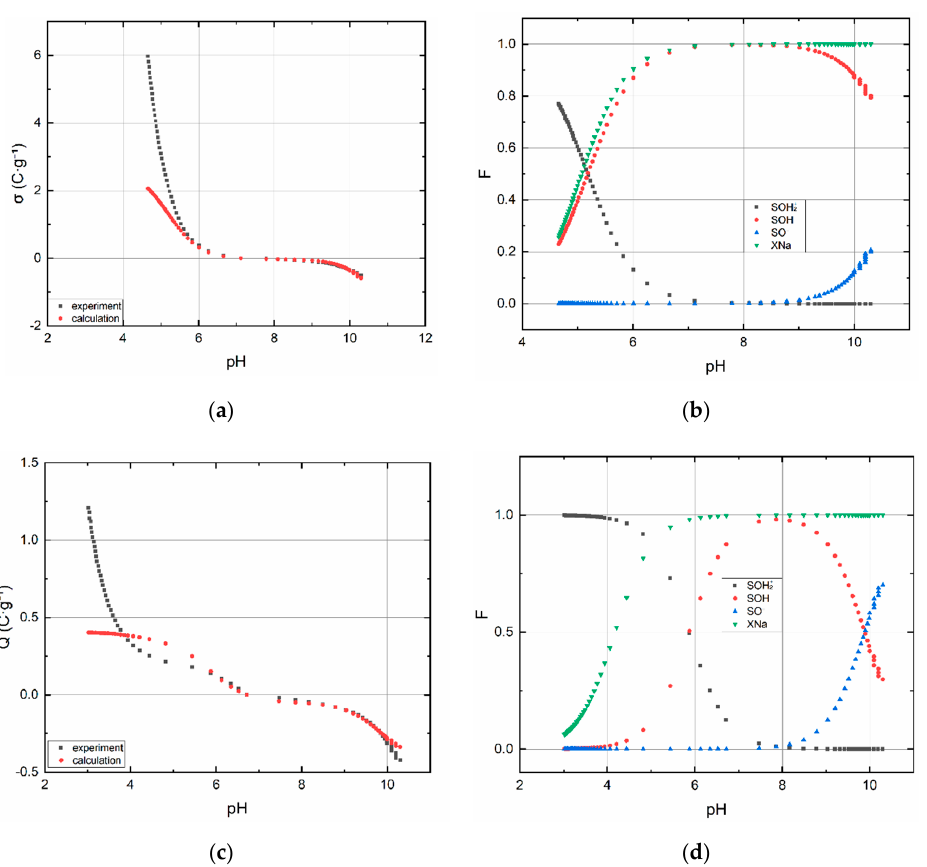
Figure 4. Surface charge dependence on the pH of BC2a ( a ) and BC2b ( c ). Species’ mole fraction dependencies on the pH of BC2a ( b ) and BC2b ( d ). CEM and IEX models were used.